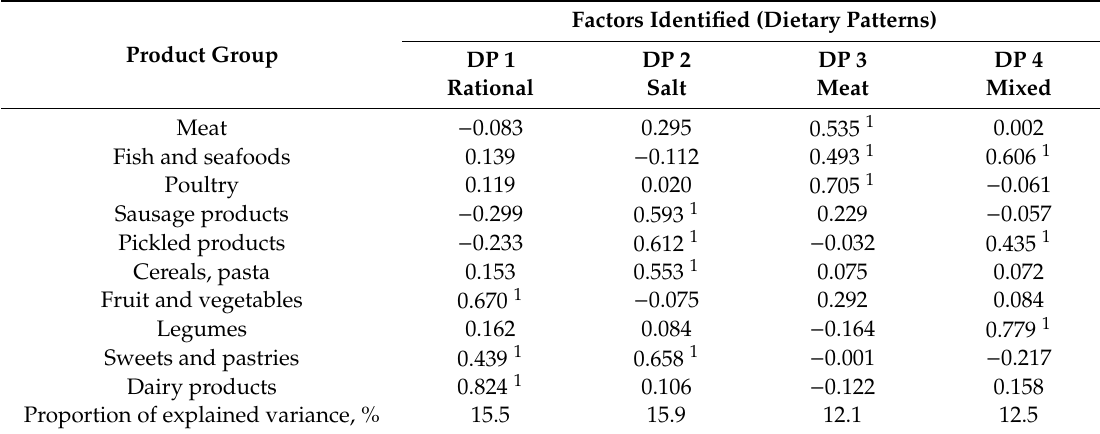
Table A14. Factor loadings of the principal dietary patterns identified (Samara region).